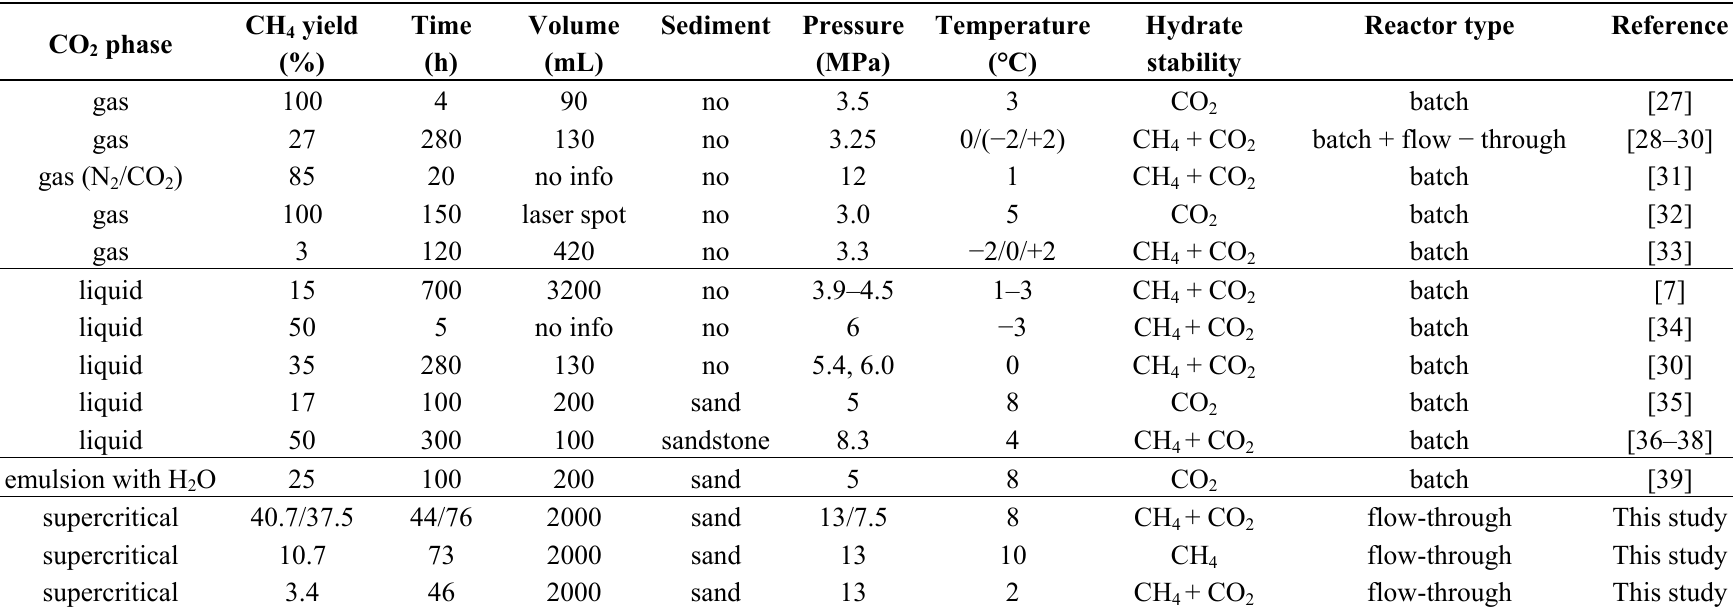
Table 3. Hydrate conversion